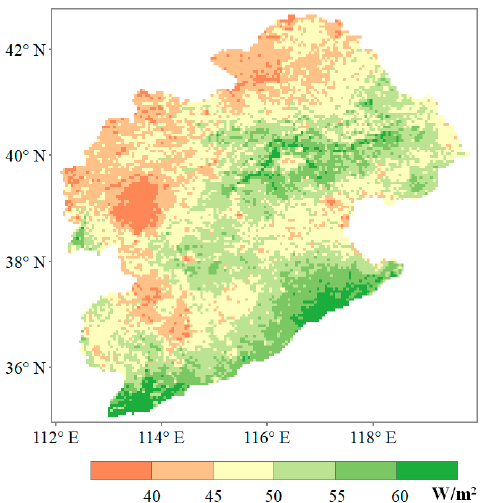
Figure 9. Maps of average annual terrestrial LE in the period from 2016 to 2018 by using GBRT algorithms over HRB with a resolution of